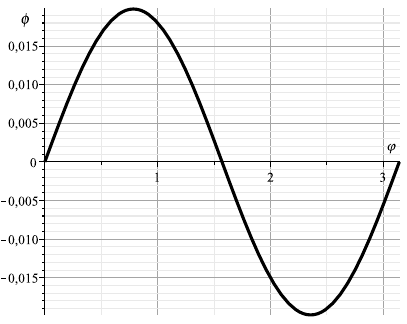
Figure 15: Plot of V ( φ ) (Example 5.2).